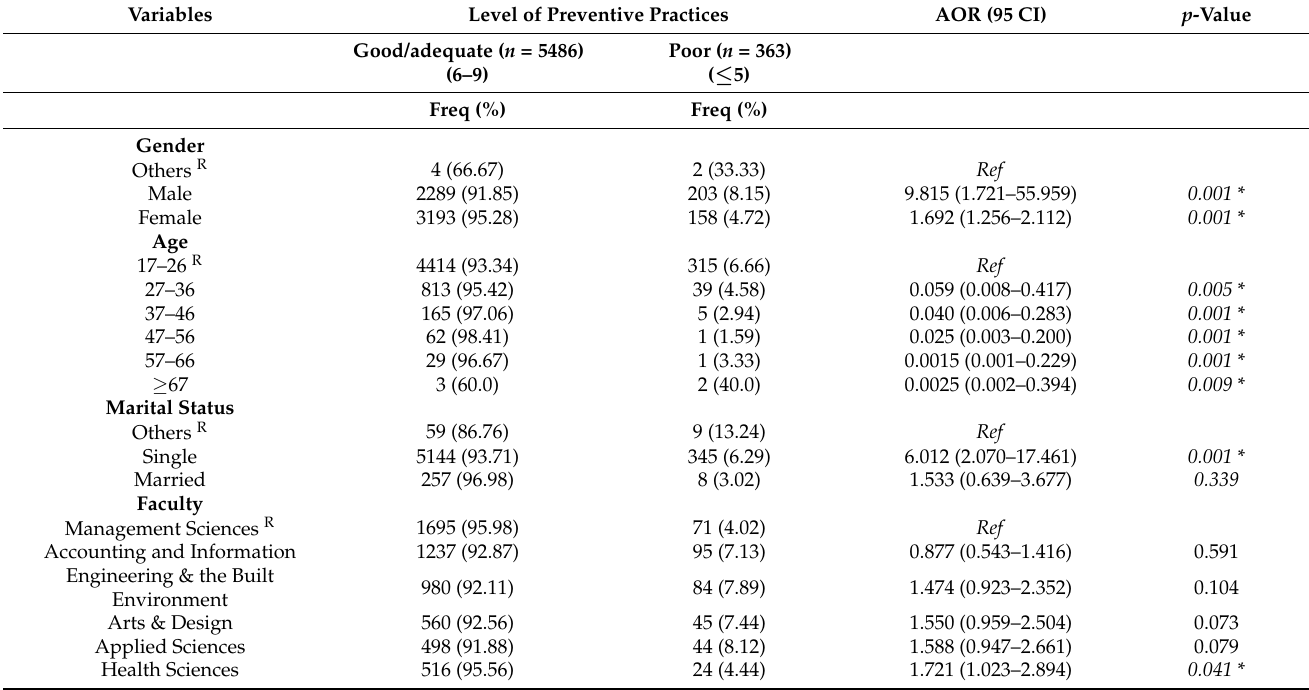
Table 6. Association between demographic characteristics and preventive practices of COVID-19 among participants from Durban University of Technology (DUT) (Multivariate LR) ( n =